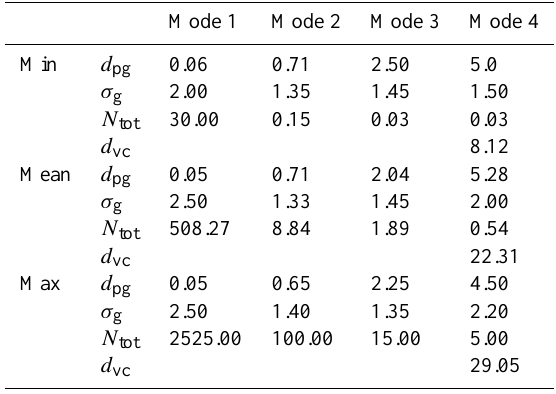
Table 4. Lognormal mode parameters and dvc of the Fennec min- imum, mean and maximum size distribution as shown in Fig. 6. Diameters are given in microns, number concentrations in scm − 3